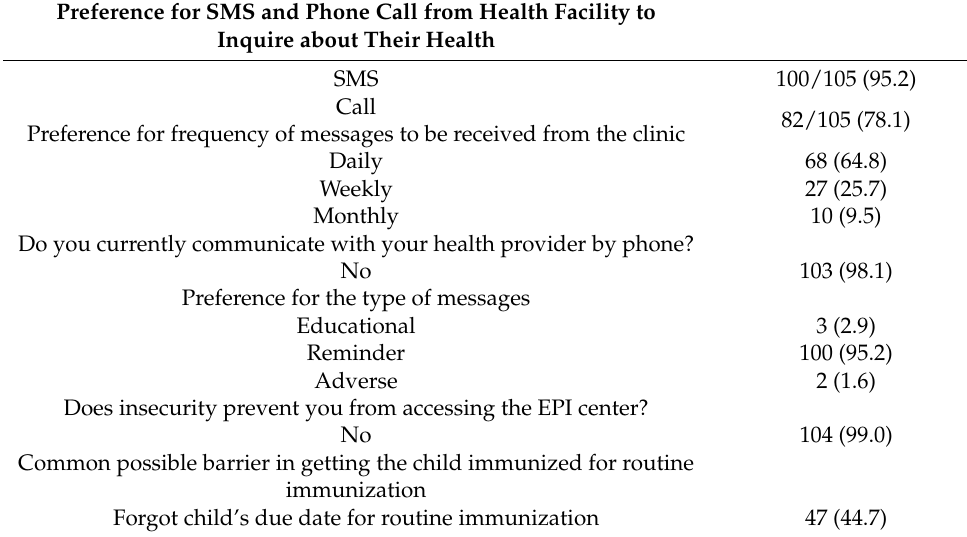
Table 3. Participants’ acceptance in receiving mobile phone messages related to routine